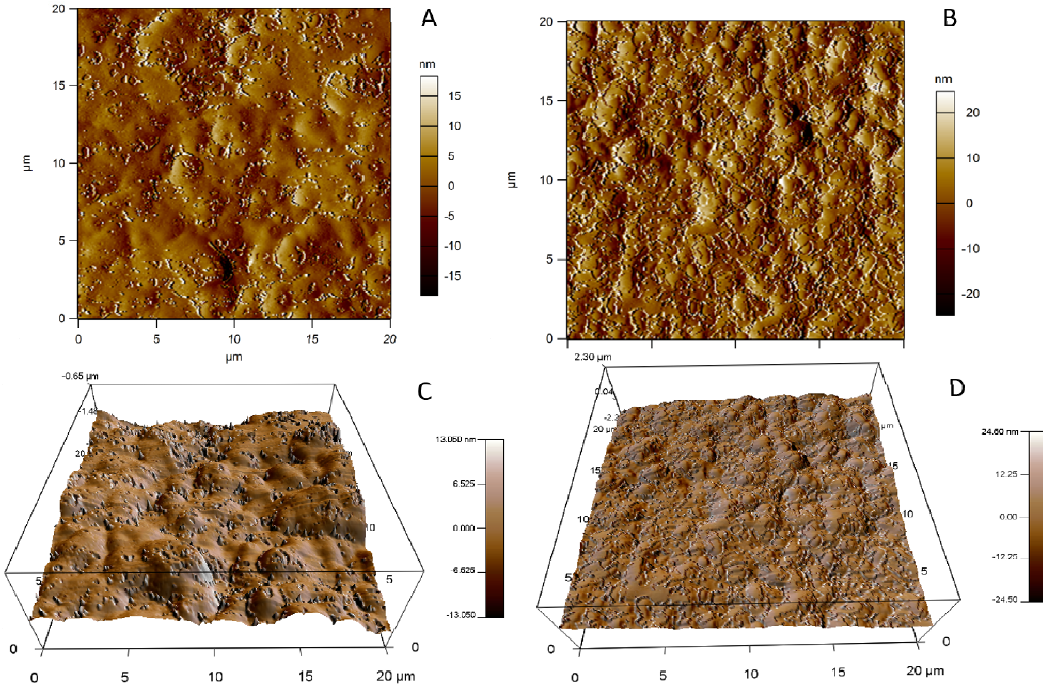
Figure 5. Topographic images of SLN-G ( A ) and SLN-Gb ( B ). Three-dimensional views of 20 × 20 µm scan of SLN-G ( C ) and SLN-Gb ( D ).